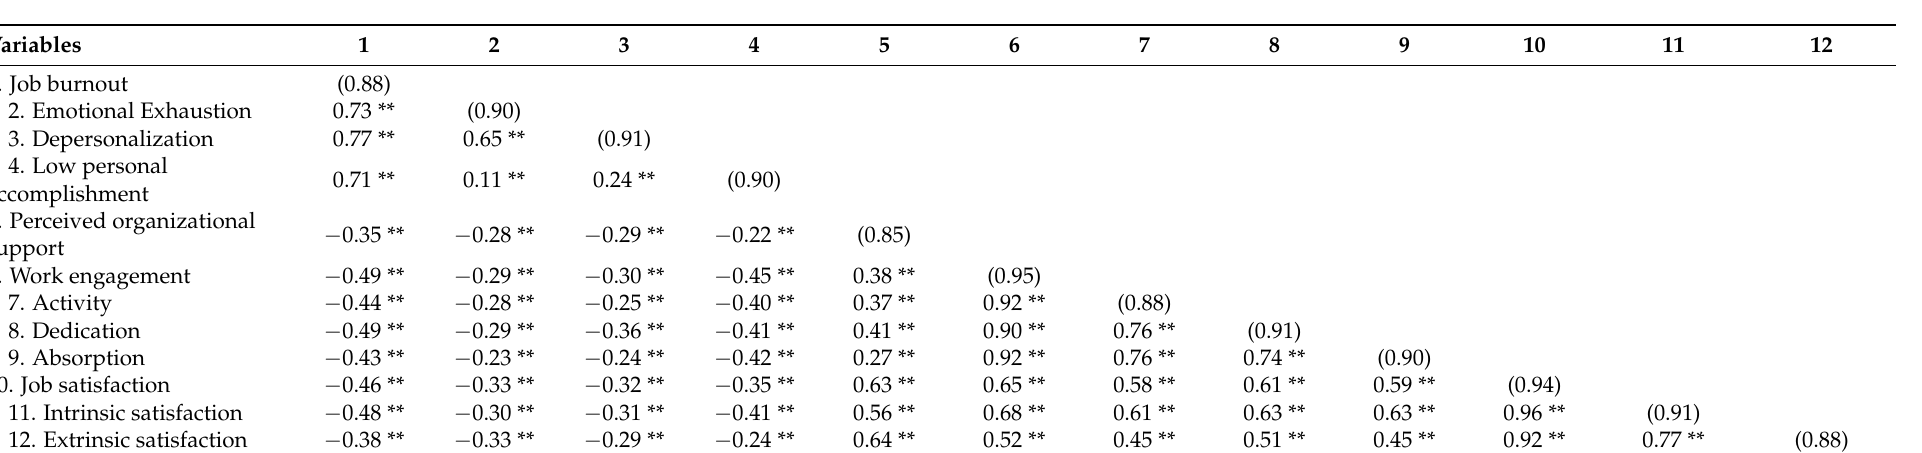
Table 4. Bivariate